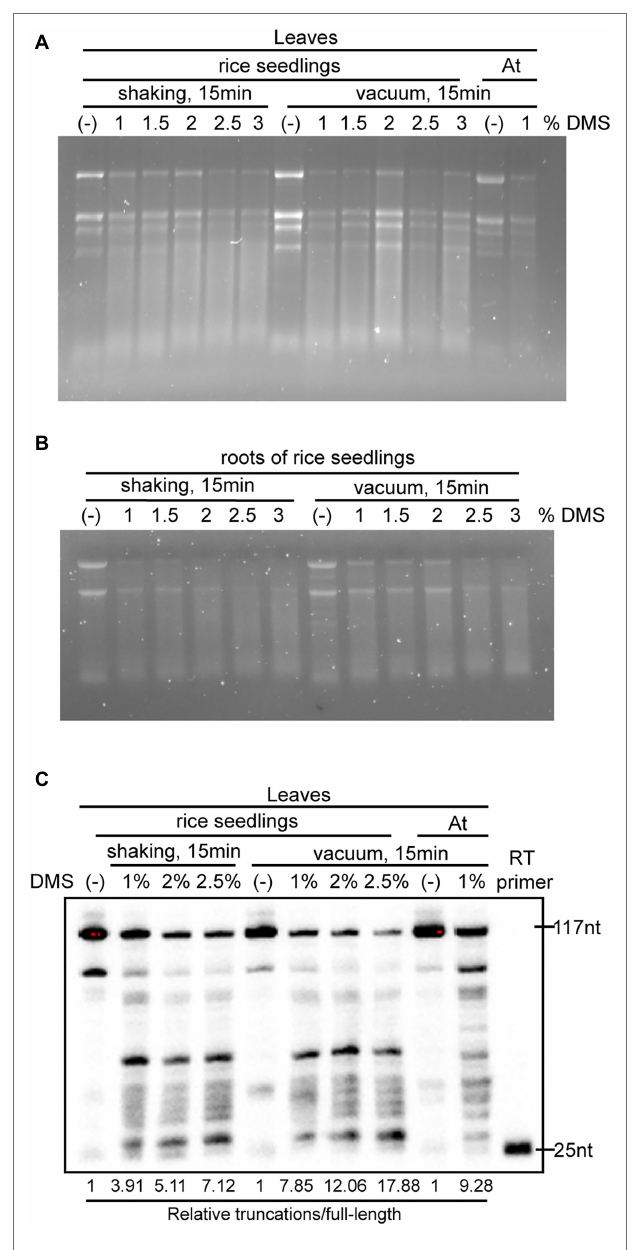
FIGURE 2 | Optimization of DMS treatment for different rice tissues. (A,B) Images of denaturing gel electrophoresis showed the integrity of total RNA from untreated and DMS-treated rice leaves (A) and roots (B) . (C) 18S rRNA primer-extension assays validated the extent of DMS modification on RNA under various DMS concentrations and incubation conditions. The extent of DMS modification is indicated by the ratio of the signal intensity of total truncations to full-length cDNA (Relative truncations/full length). The ratio of truncations/full length was normalized to that of untreated samples, where the number was arbitrarily set to